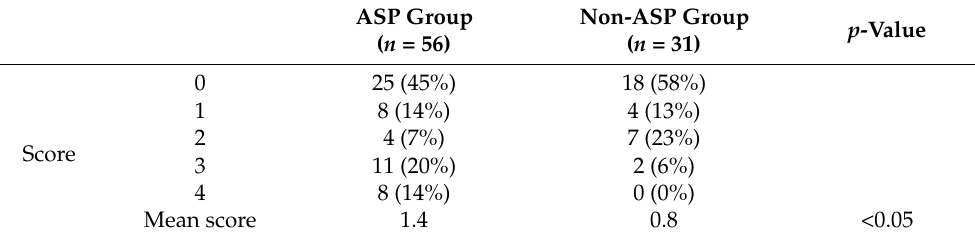
Table 4. Score of facet joint